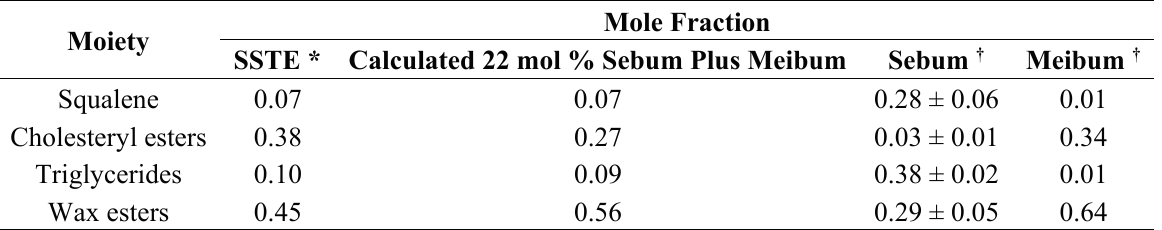
Table 3. Mole fractions of components of SSTE from a 61-year-old Caucasian male.